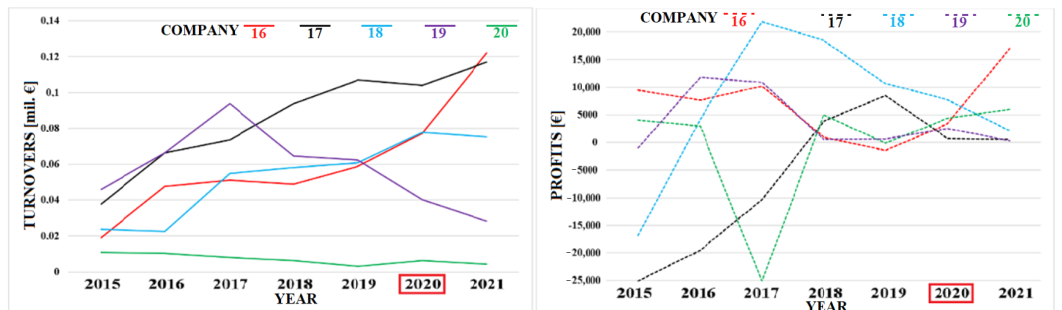
Figure 6. Development of turnovers and profits of the wine companies with turnovers of EUR 0.07 to 0.5 million annually [56].